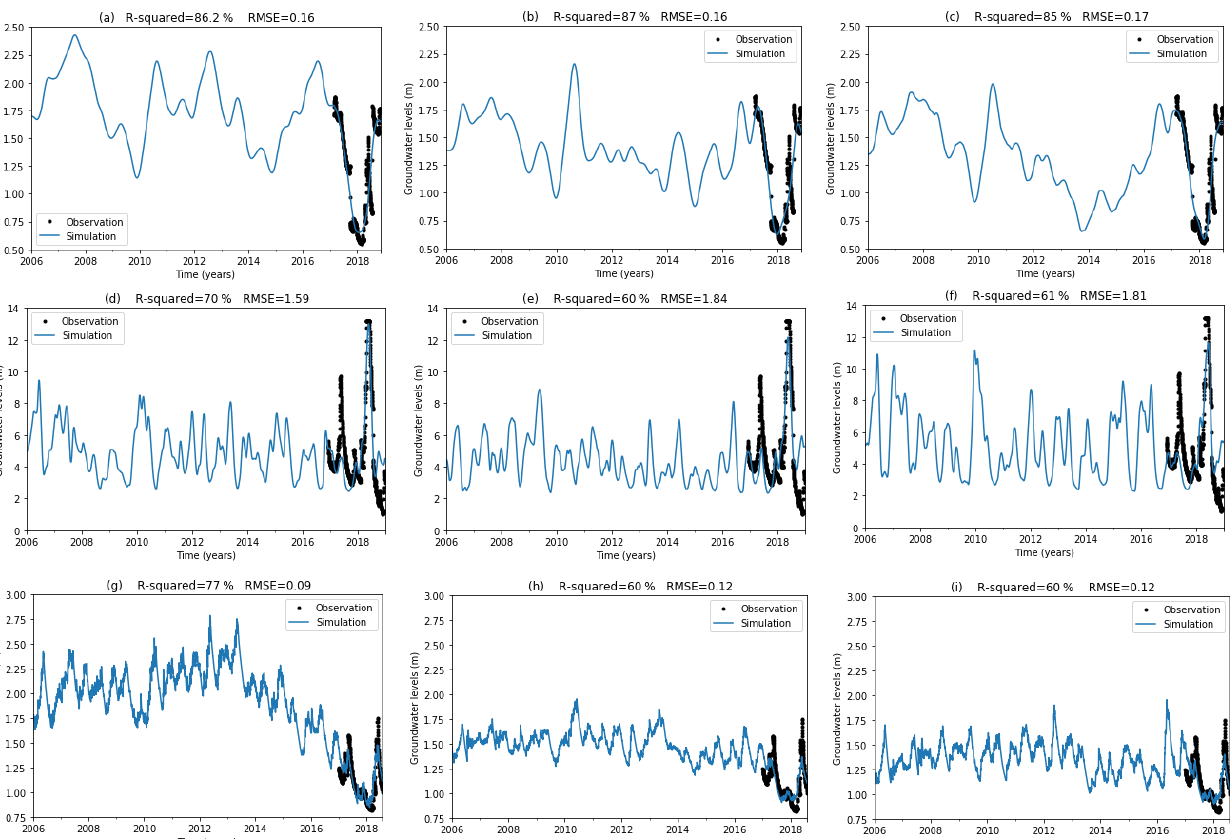
Figure 4. Groundwater simulation with TFN model. (a–c) TFN model calibrated with groundwater observations from Nyamyumba ground- water observation well; rainfall and potential evaporation (Ep) time series as model inputs from three meteorological stations: (a) Rubengera (b) Kanama, and (c) Gisenyi located in Kivu catchment. (d–f) TFN model calibrated with groundwater observations from Rugabano ground- water observation well; rainfall and Ep time series as model inputs from three meteorological stations: (d) Byimana, (e) Kibangu, and (f) Rwaza located in upper Nyabarongo catchment. (g–i) TFN model calibrated with groundwater observations from Cyuve groundwater obser- vation well; rainfall and Ep time series as model inputs from three meteorological stations: (g) Ruhengeri, (h) Bigogwe, and (i) Rwankeri located in Mukungwa